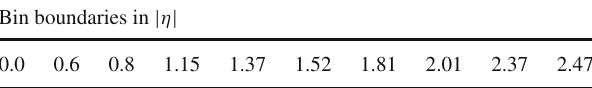
Table 2 Boundaries in absolute cluster pseudorapidity used to define the nine bins for the LH pdfs and LH discriminant requirements Bin boundaries in | η |